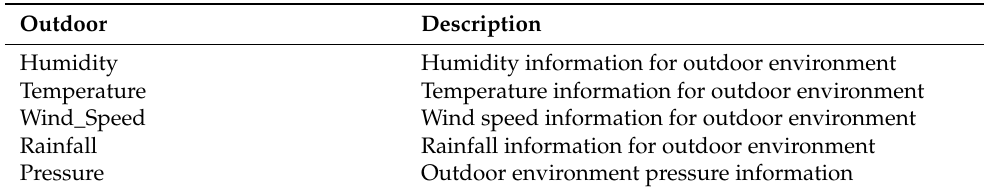
Table 4. Outdoor environment feature information.